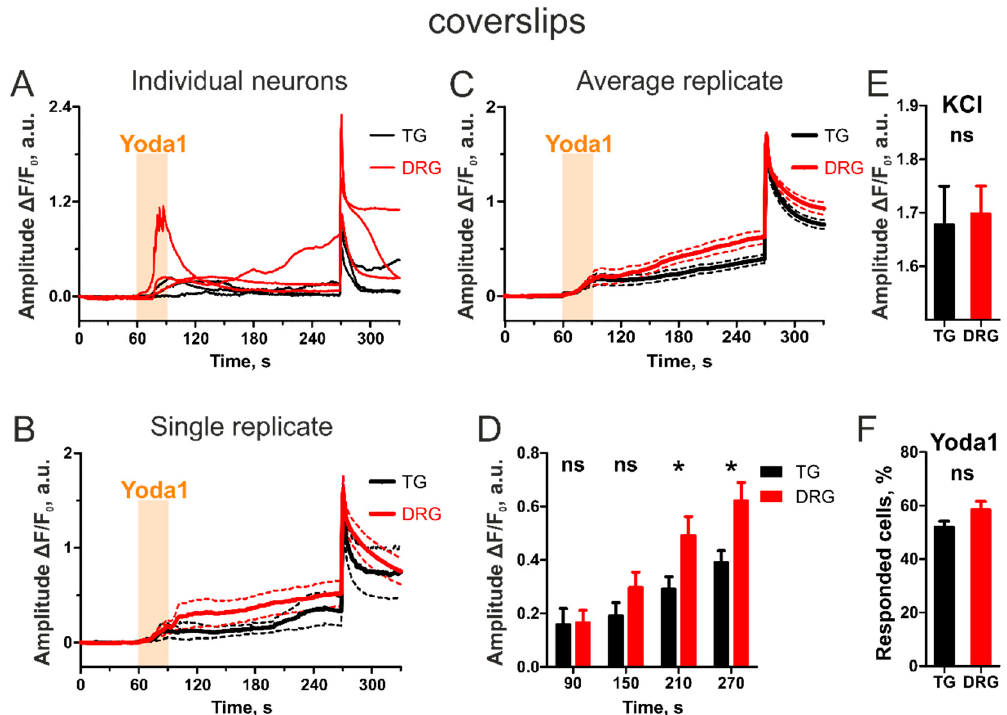
Figure 1. Yoda1-induced transients in TG vs. DRG neurons in a conventional calcium imaging setup utilizing fast application system. ( A ) Sample traces of individual TG and DRG neurons. ( B ) Average neuronal responses of TG and DRG cells obtained from single replicate coverslips. ( C ) Average neuronal responses of TG vs. DRG neurons ( n = 9 coverslips). ( D ) A histogram of the results of unpaired Student’s t -test at different timepoints during Yoda1 washout. Significantly higher DRG responses are seen only after 2 min of washout ( n = 9 coverslips, * p < 0.05 by unpaired Student’s t -test). ( E ) In contrast to Yoda1 responses, KCl evokes similar transients in both groups of neurons. ( F ) Dorsal